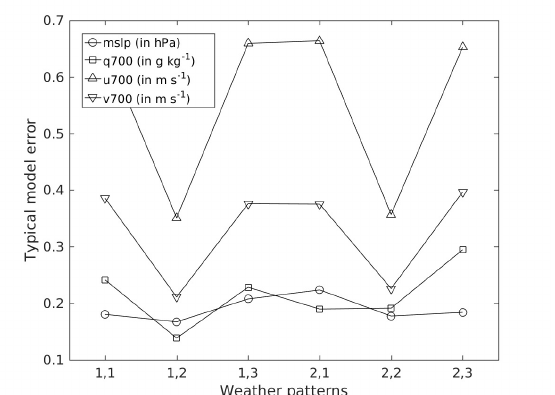
Figure 8. Typical model error for every variable as a function of the weather